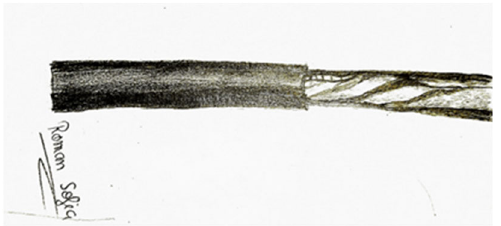
Figure 1. Solid T ‐ reamer for the distal tibial nail fragment removal. Figure 1. Solid T-reamer for the distal tibial nail fragment